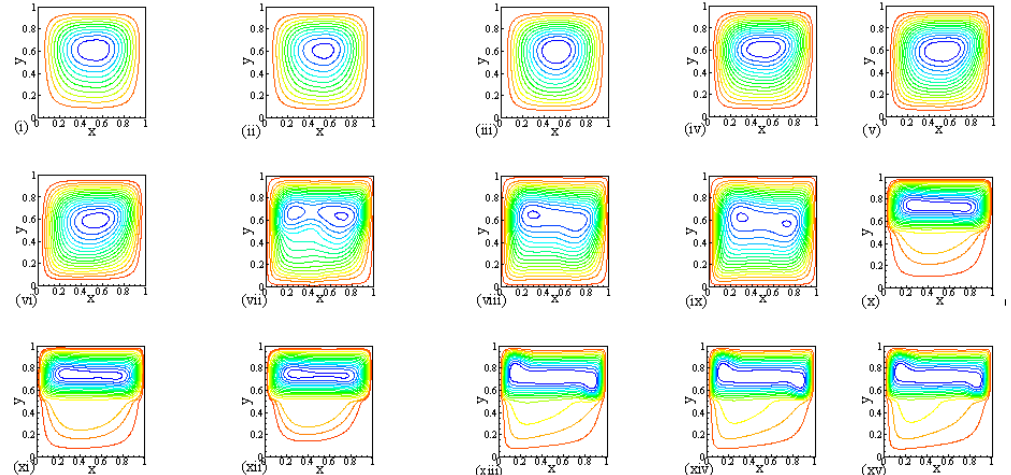
Fig. 4 (a). Streamlines of horizontal porous layer at (i)  =0.4 (ii)  =0.6 (iii)  =0.9 while Ra = 10 3 , Da = 10 -2 , (iv)  =0.4 (v)  =0.6 (vi)  =0.9 while Ra = 10 4 , Da = 10 -2 , (vii)  =0.4 (viii)  =0.6 (ix)  =0.9 while Ra = 10 5 , Da = 10 -2 , (x)  =0.4 (xi) 𝜀 = 0.6 (xii)  =0.9 while Ra = 10 5 , Da = 10 -4 and (xiii)  =0.4 (xiv)  =0.6 (xv)  =0.9 while Ra = 10 6 , Da = 10 -4